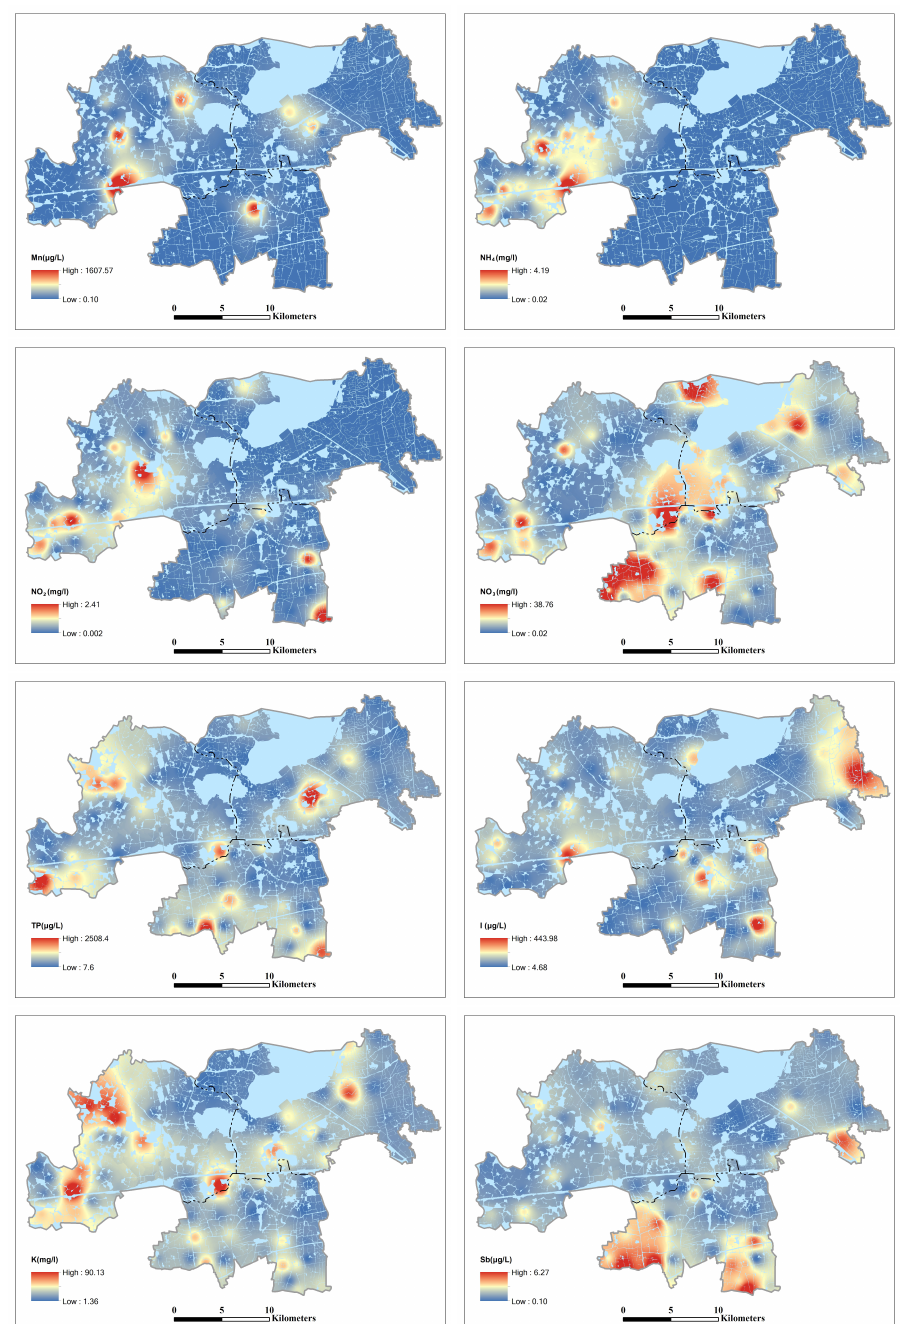
Figure 4. Spatial distribution of Mn , NH +